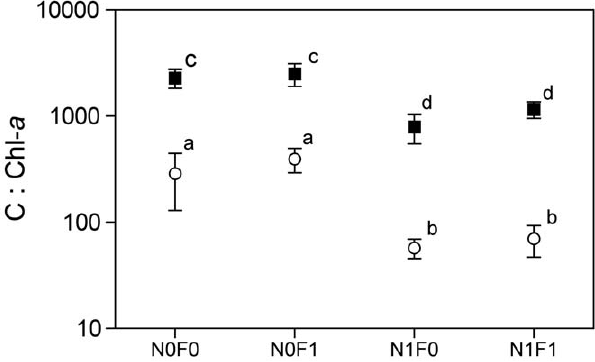
Figure 3. Periphyton Carbon:Chlorophyll-a ratio in high ( # ) and low ( & ) light conditions. Treatment abbreviations are the same as in figure 1. Each point represents averaged values of three weeks ( n =12) 6 SE. Different letters above bars represent significant statistical differences (Two-way ANOVA with Contrast Analysis as post hoc test, P ,